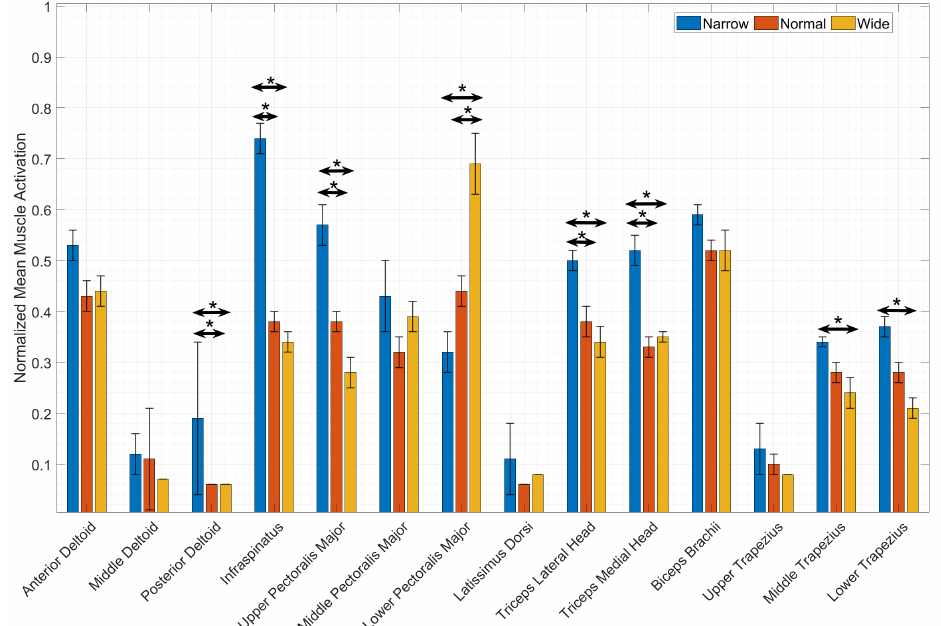
Figure 5. The mean and standard deviation of normalized muscle activities for 14 muscles: the anterior deltoid, middle deltoid, posterior deltoid, infraspinatus, upper pectoralis major, middle pectoralis major, lower pectoralis major, latissimus dorsi, triceps lateral, triceps medial, biceps brachii, upper trapezius, middle trapezius, and lower trapezius muscles in three medial-lateral positions of palms (narrow, normal, and wide). The star sign indicates p -values < 0.05 with respect to Tukey– Kramer post-hoc significant difference criterion.